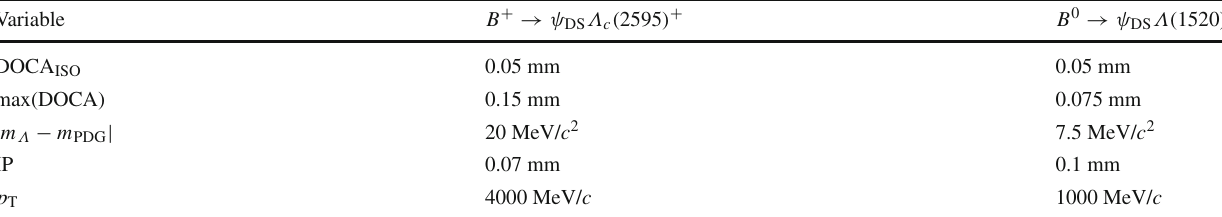
Table 1 Requirements for each B → ψ DS Λ decay mode. These values mass window in the relevant reconstructed invariant Λ mass around its known mass [21]. The IP and p T cuts are applied to the Λ( 1520 ) and have been chosen in order to maximize the discrimination between sig- Λ ( 2595 ) + candidates. All the track cuts, introduced in Sect. 2, have nal and background. Here, “max(DOCA)” refers to the maximum value c of all the DOCA computed for the two-track combinations among the also been imposed for every decay mode Λ( 1520 ) and Λ ( 2595 ) + daughters, and | m Λ − m | describes the c PDG